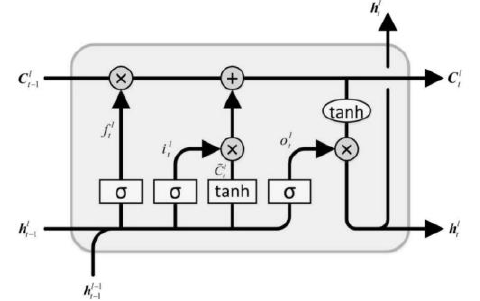
Figure 6. Diagram of a LSTM cell [27].